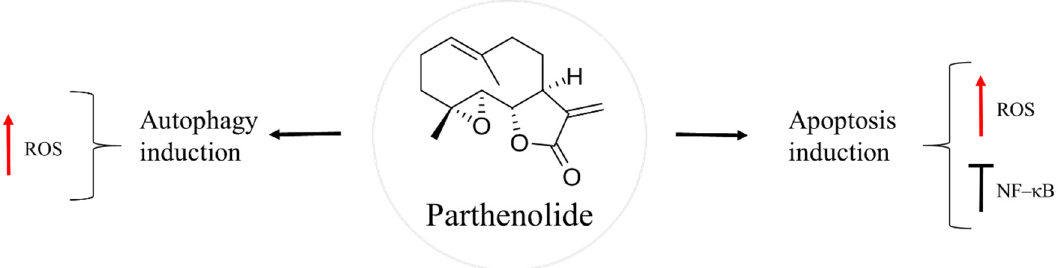
Figure 5. Parthenolide in osteosarcoma inhibition.